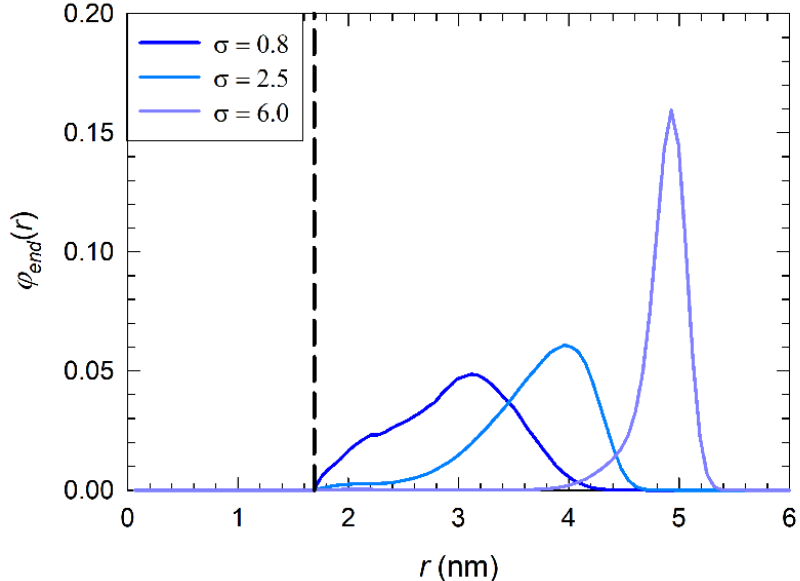
Figure 4. End monomer distribution, 𝜑 𝑒𝑛𝑑 (𝑟) , of alkylamine chains with 𝑁 = 12 shown only for selected grafting densities 𝜎 . The black dashed line indicates the position of PEG/PEI surface. A complete set of end-monomer distributions is reported in Supporting Information in Figure S3.